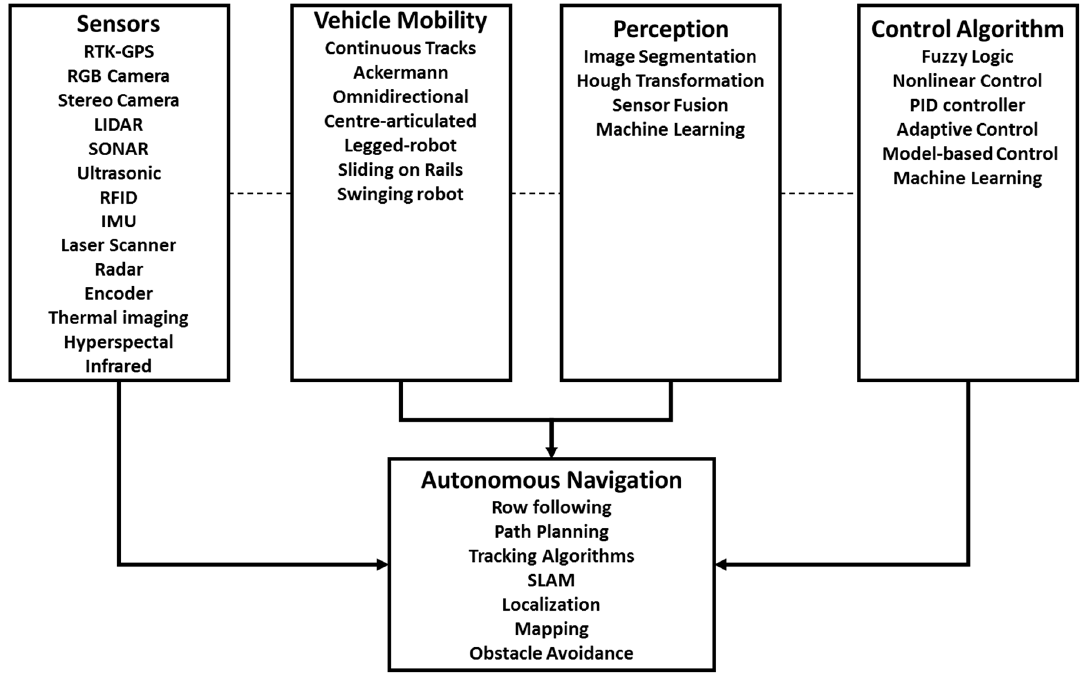
Figure 1. Autonomous navigation modules.